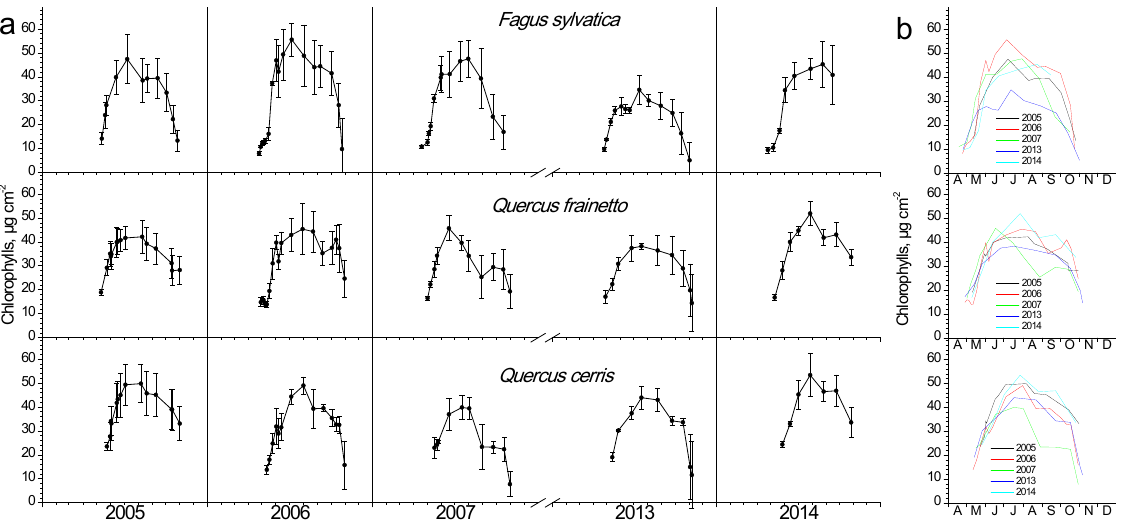
Figure 4. Seasonal fluctuation of leaf chlorophyll content for the three studied species. ( a ) Data for each year separately (average values ± SD for each date) ( b ) data for all years (only average values per date, error bars are not shown for clarity reasons).